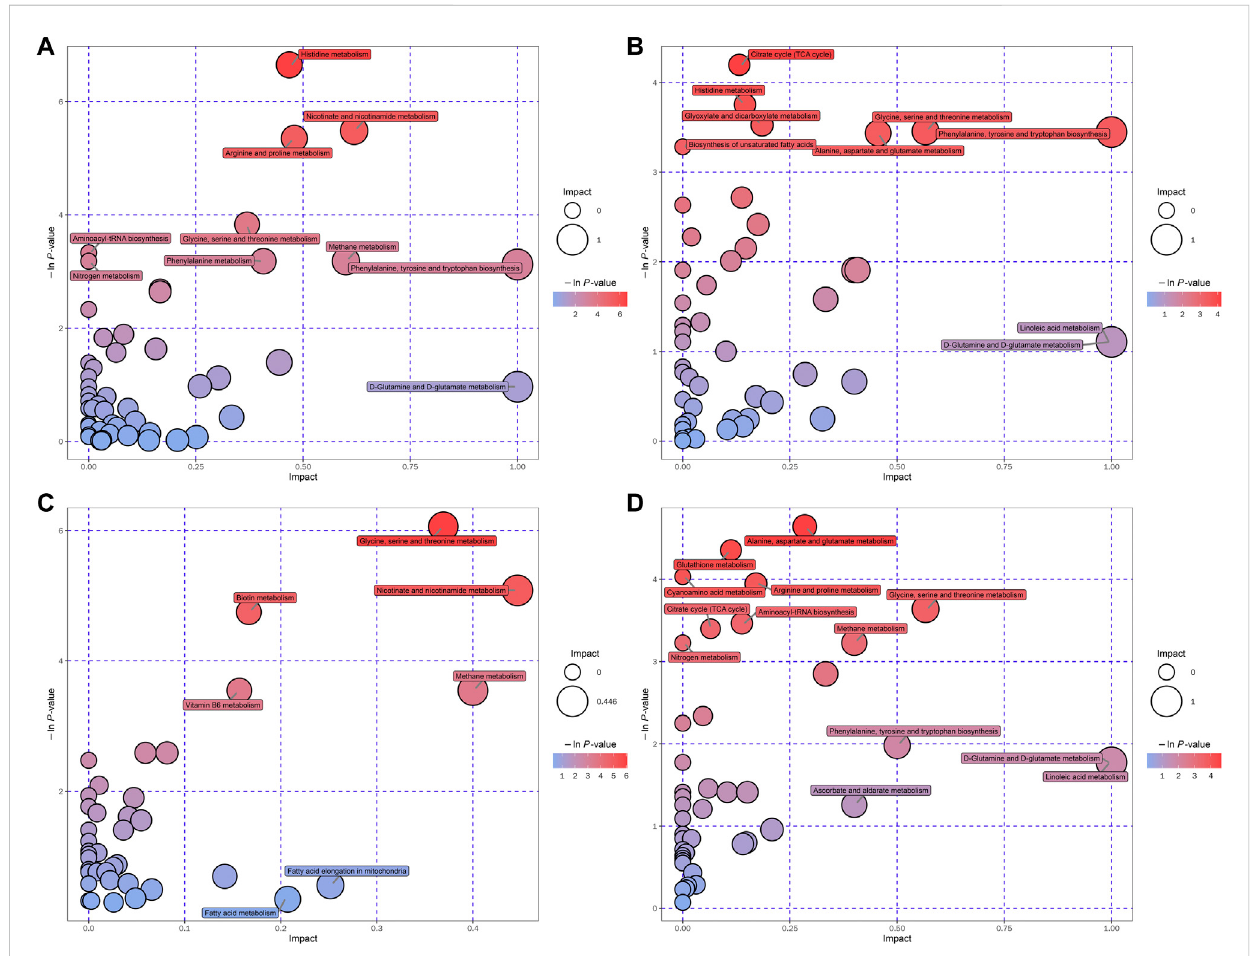
FIGURE 8 Bubble plots of the metabolic pathway analysis. The main metabolic pathways changed by CKD in negative (A) and positive (B) ion mode. The main metabolic pathways responded to AM and CZ treatment in negative (C) and positive (D) ion